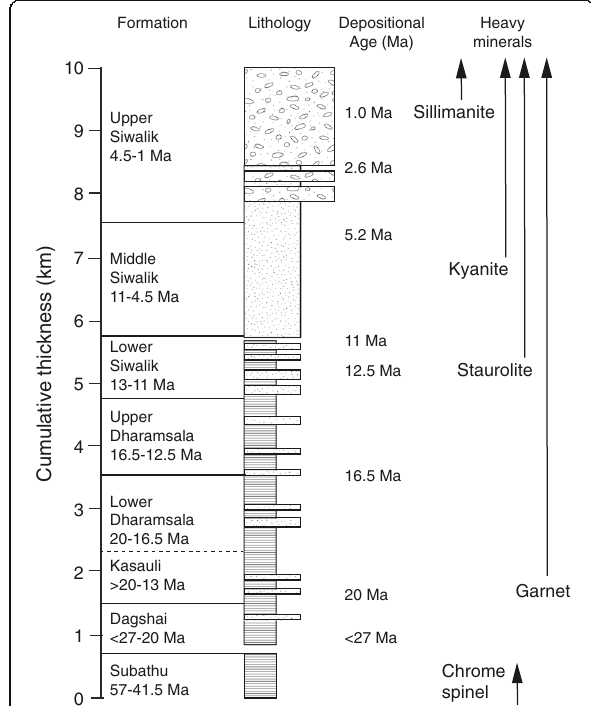
Fig. 5 Simplified stratigraphy of the western Himalayan foreland basin derived from the work of Jain et al. (2009), showing the general coarsening up-section and the appearance of a variety of higher grade metamorphic minerals that might be associated with the unroofing of the Greater and Inner Lesser